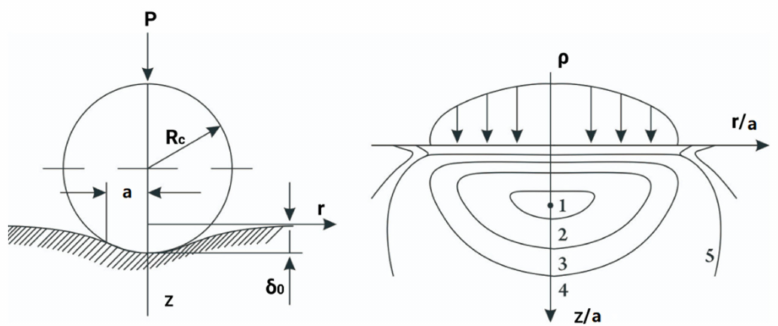
Figure 2. Calculation diagram and pressure distribution of the ball in the case of